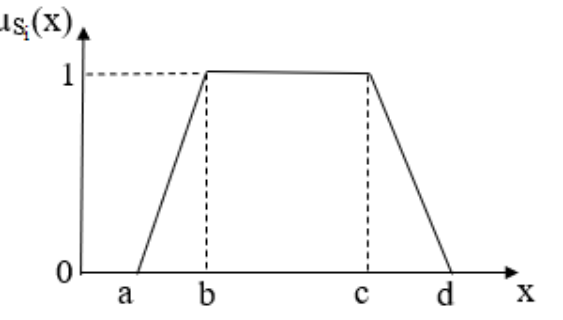
Figure 3. Fuzzification for trapezoidal membership function .